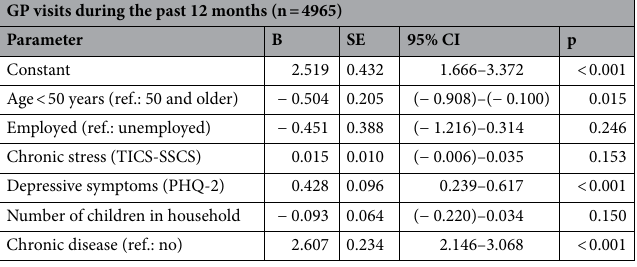
Table 2. DEGS1: Regression model on factors influencing GP visits (past 12